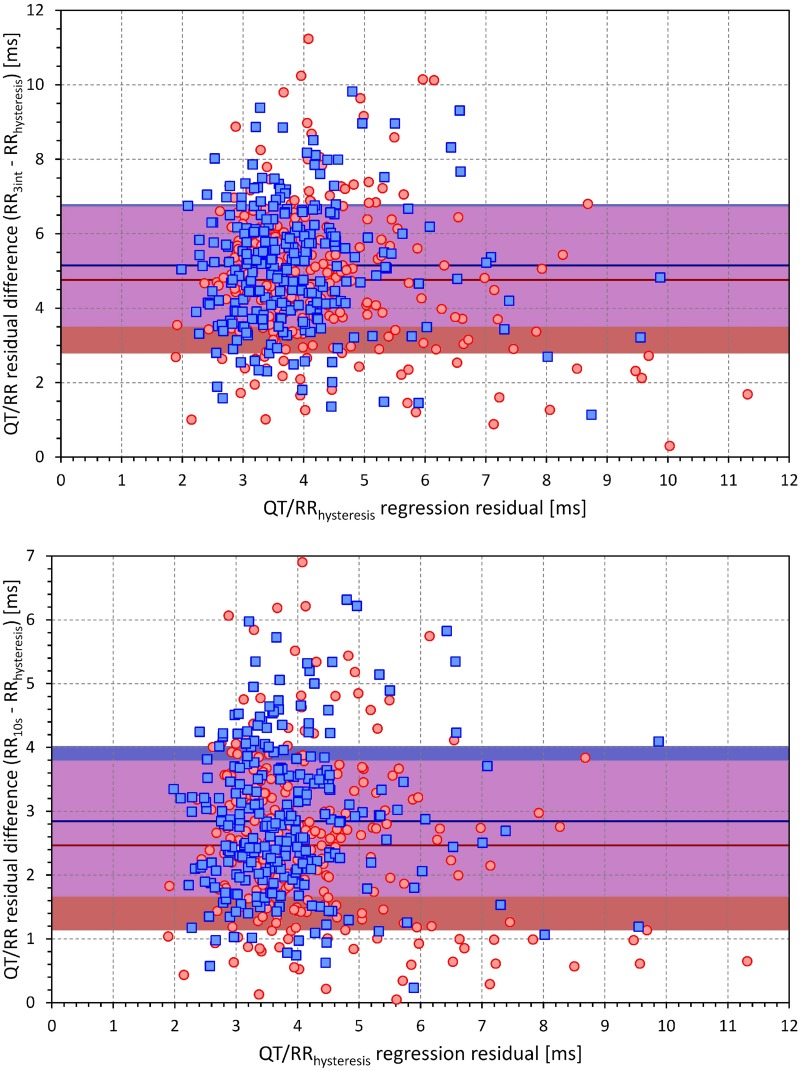
Scatter diagrams between the curvilinear QT/RR regression residuals involving QT/RR hysteresis correction (horizontal axes) and the increases in the residuals when using three RR interval averages (top) and 10-s RR interval averages (bottom) instead of QT/RR hysteresis correction. Red circles and blue squares correspond to female and male subjects, respectively. Dark red and dark blue lines are means of the residual increase in females and males, respectively. The light red and light blue bands show the intervals of mean ± standard deviation of the sex-specific residual increases. The violet bands are the overlaps between the standard deviation bands of both sexes.